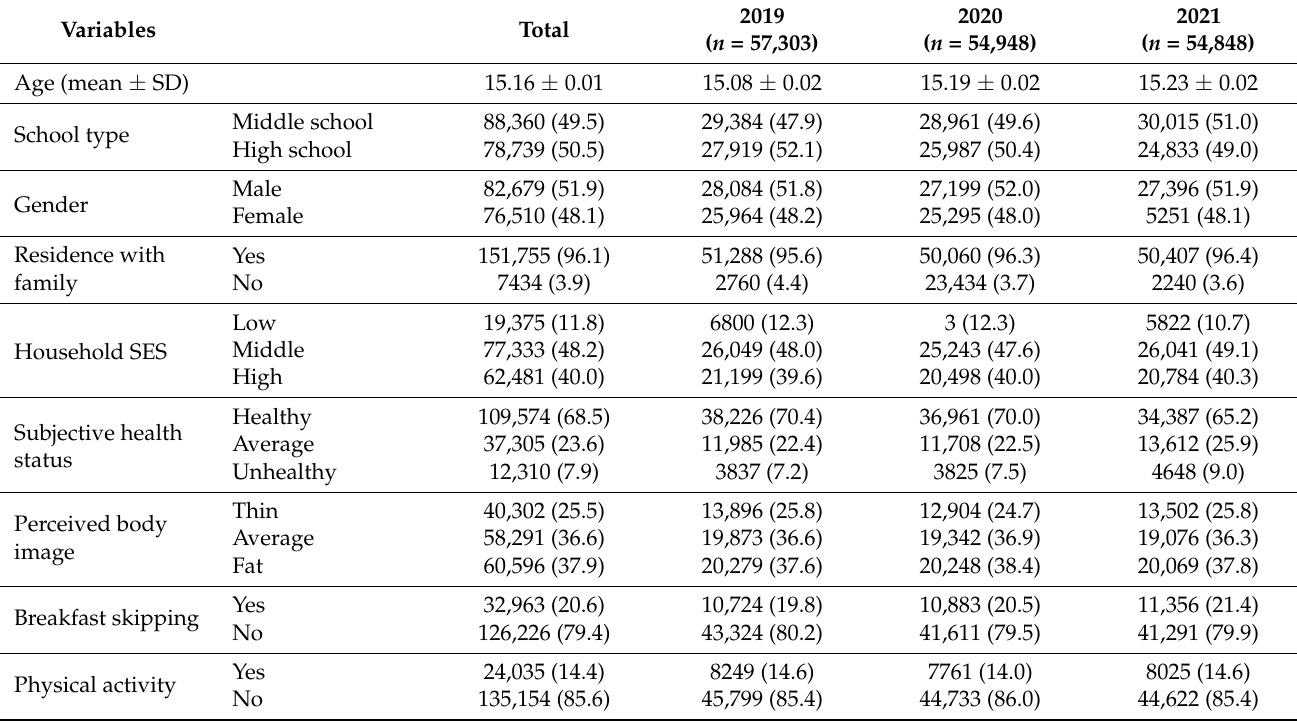
Table 1. General and health-related characteristics of the subjects ( N = 167,099), n